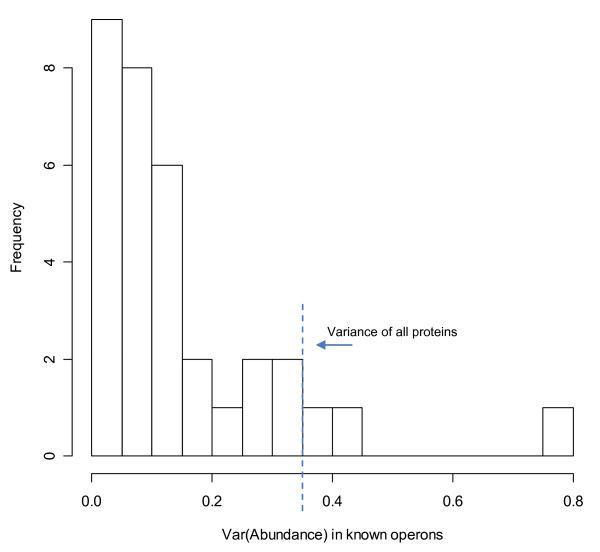
Variance of abundance within known operons. Only the 33 operons for which we have abundance data of 3 or more proteins are considered. The variance of all 1050 proteins is 0.35 and shown as dashed line. Low variance within an operon shows that the abundance of its proteins is similar. Here in 91% (30 of 33) of all operons the variance is lower than the variance of all proteins (left to the vertical bar). Copy number values are distributed according to the extreme value distribution and were therefore logarithmized for better representation.